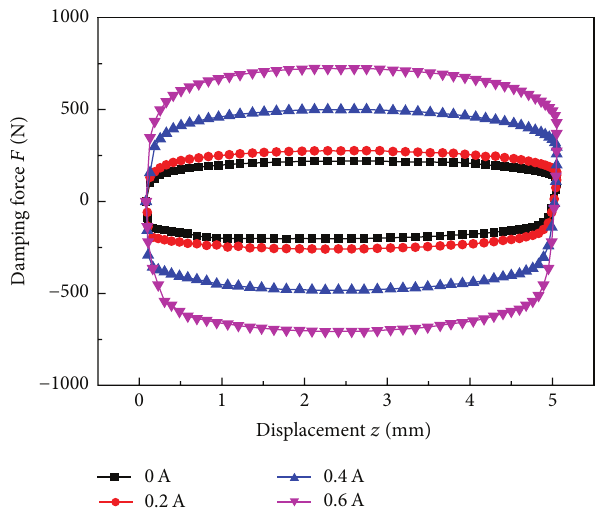
Figure 6: Damping force versus displacement at the different applied current.